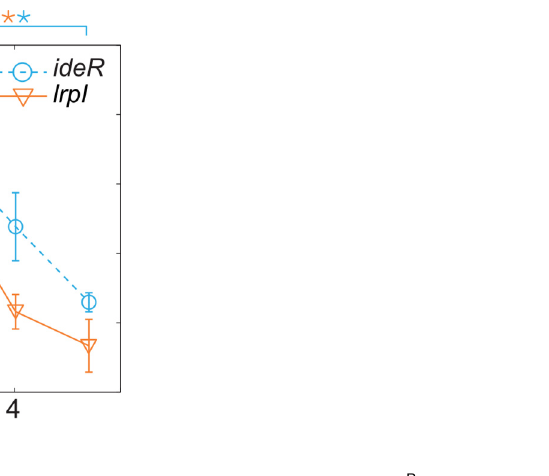
Fig 5. Gene expression measurements for ideR . In a well-characterized interaction, σ B acts as the sole transcriptional regulator of ideR . mRNA of ideR exhibits a non-monotonic response similar to that of lrpI , suggesting that the non-monotonic dynamics are a result of a post-translational regulation of σ B activity. ( * p (cid:1)